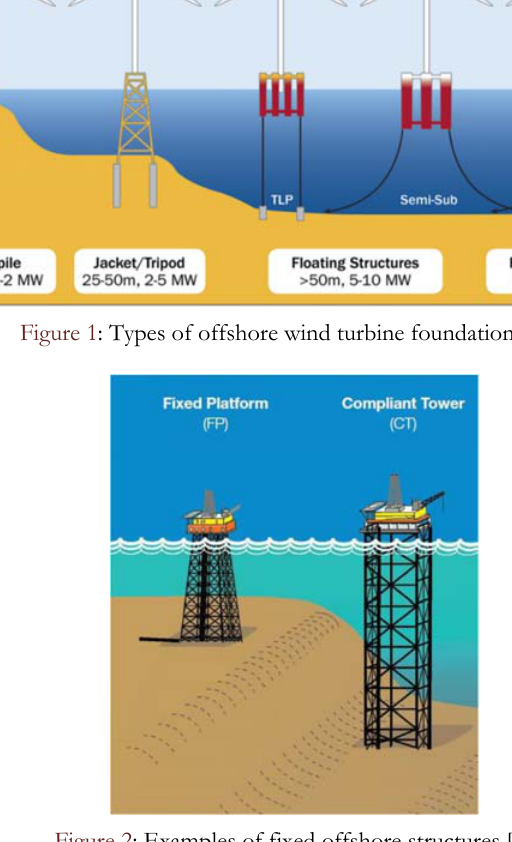
Figure 2: Examples of fixed offshore structures